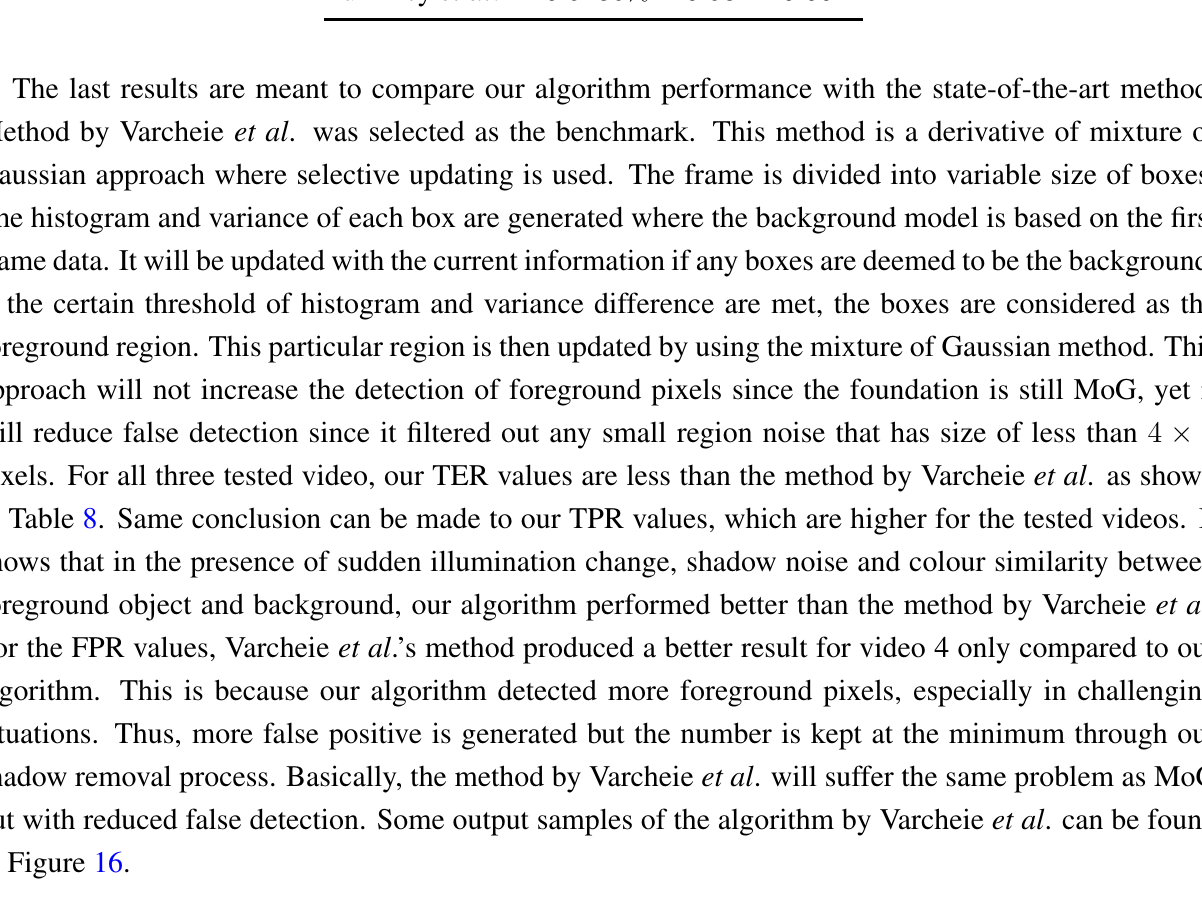
Table 8. Performance comparison between the methods by Varcheie et al . and Zulkifley et al